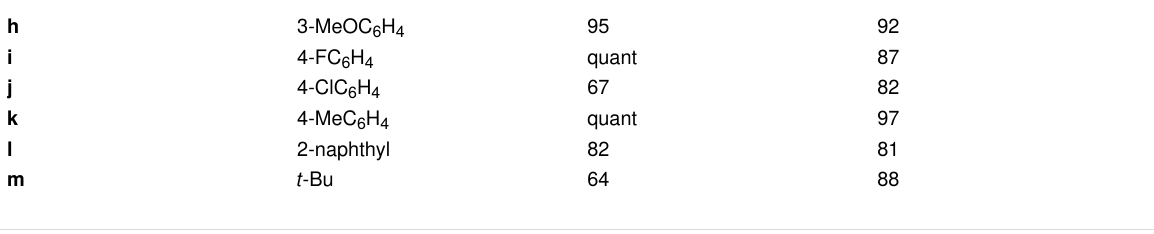
Table 20: Intramolecular aza-Michael addition reaction catalyzed by chiral phosphoric acid. (continued)